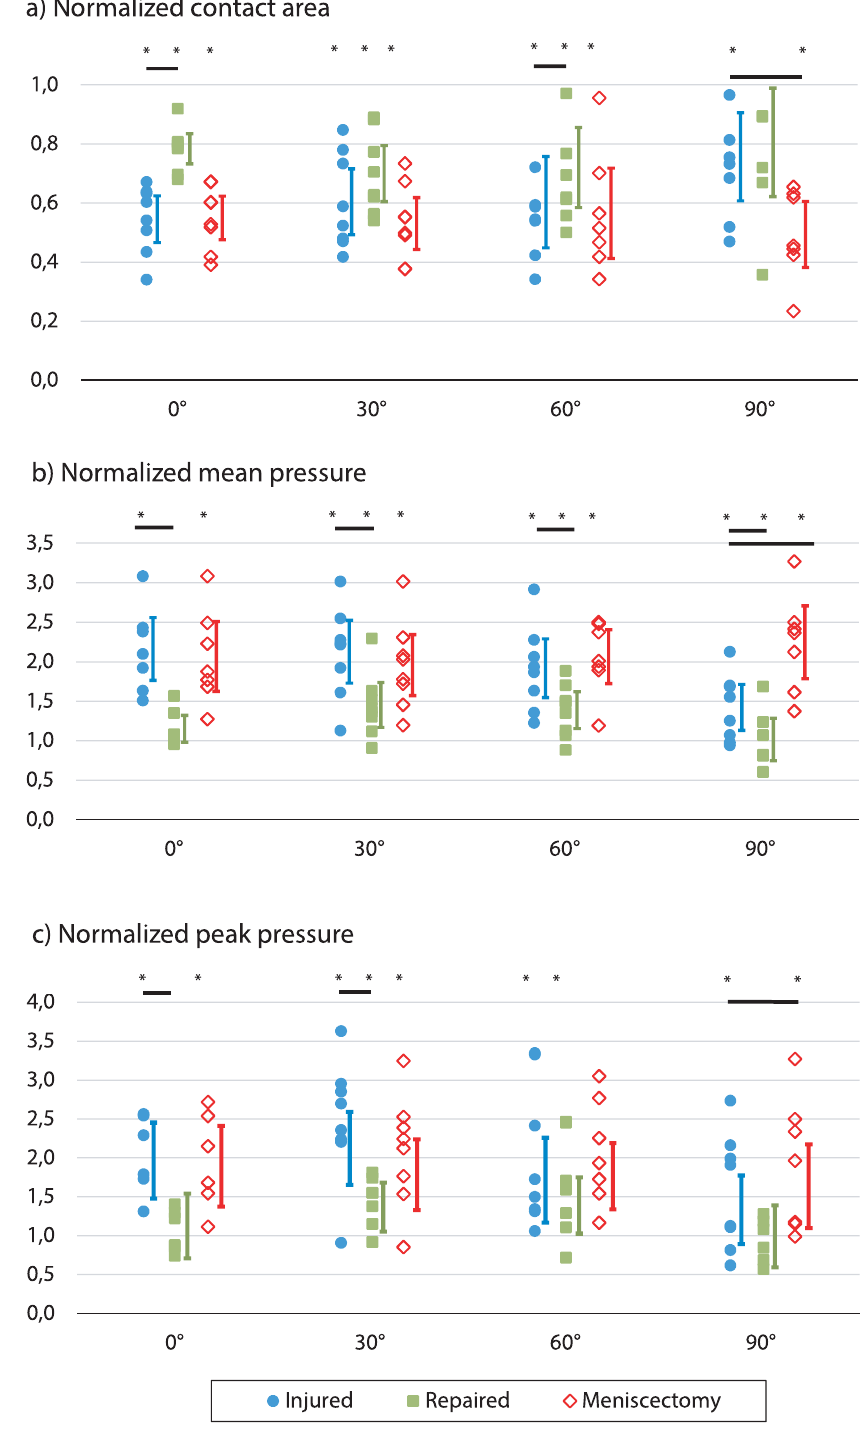
Figure 4. Normalized contact area ( a ), mean pressure ( b ), and maximum pressure ( c ) at the lateral compartment for the three altered meniscal conditions (injured, repaired, and total meniscectomy) for the four knee flexion angles tested; The vertical line near each dot group represents the 95% CI interval of the mean for the group data. Horizontal lines represent significant differences between groups in the preplanned pairwise comparisons. *Significant difference with respect to the intact